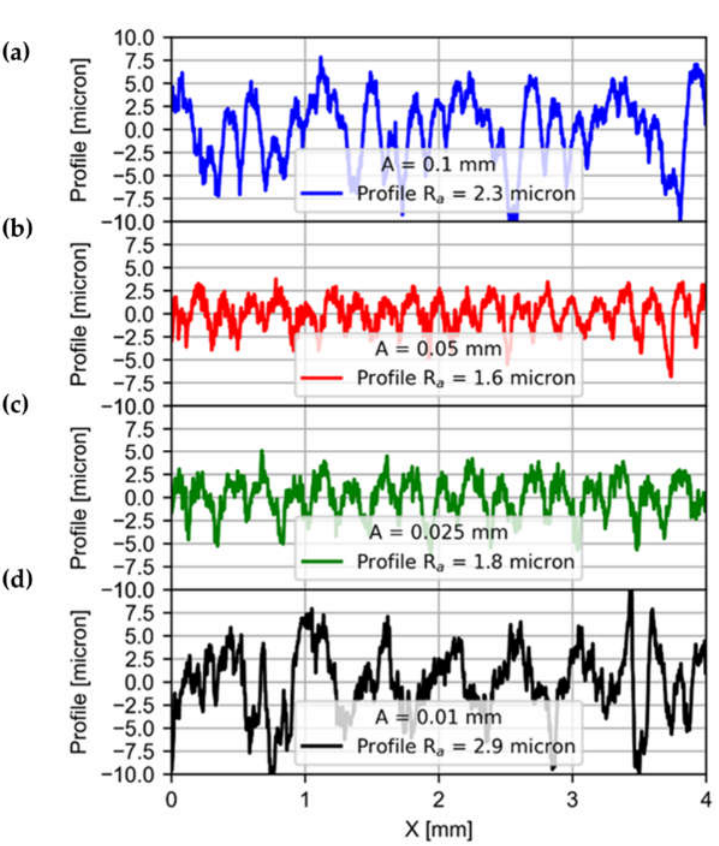
Figure 14. Roughness profiles for tests with variable vibration amplitudes: ( a ) A = 0.1 mm, ( b ) A = 0.05 mm, ( c ) A = 0.025 mm and ( d ) A = 0.01 mm, all with f = 4 Hz (see Table 2 tests 19, 20, 21 and 22).